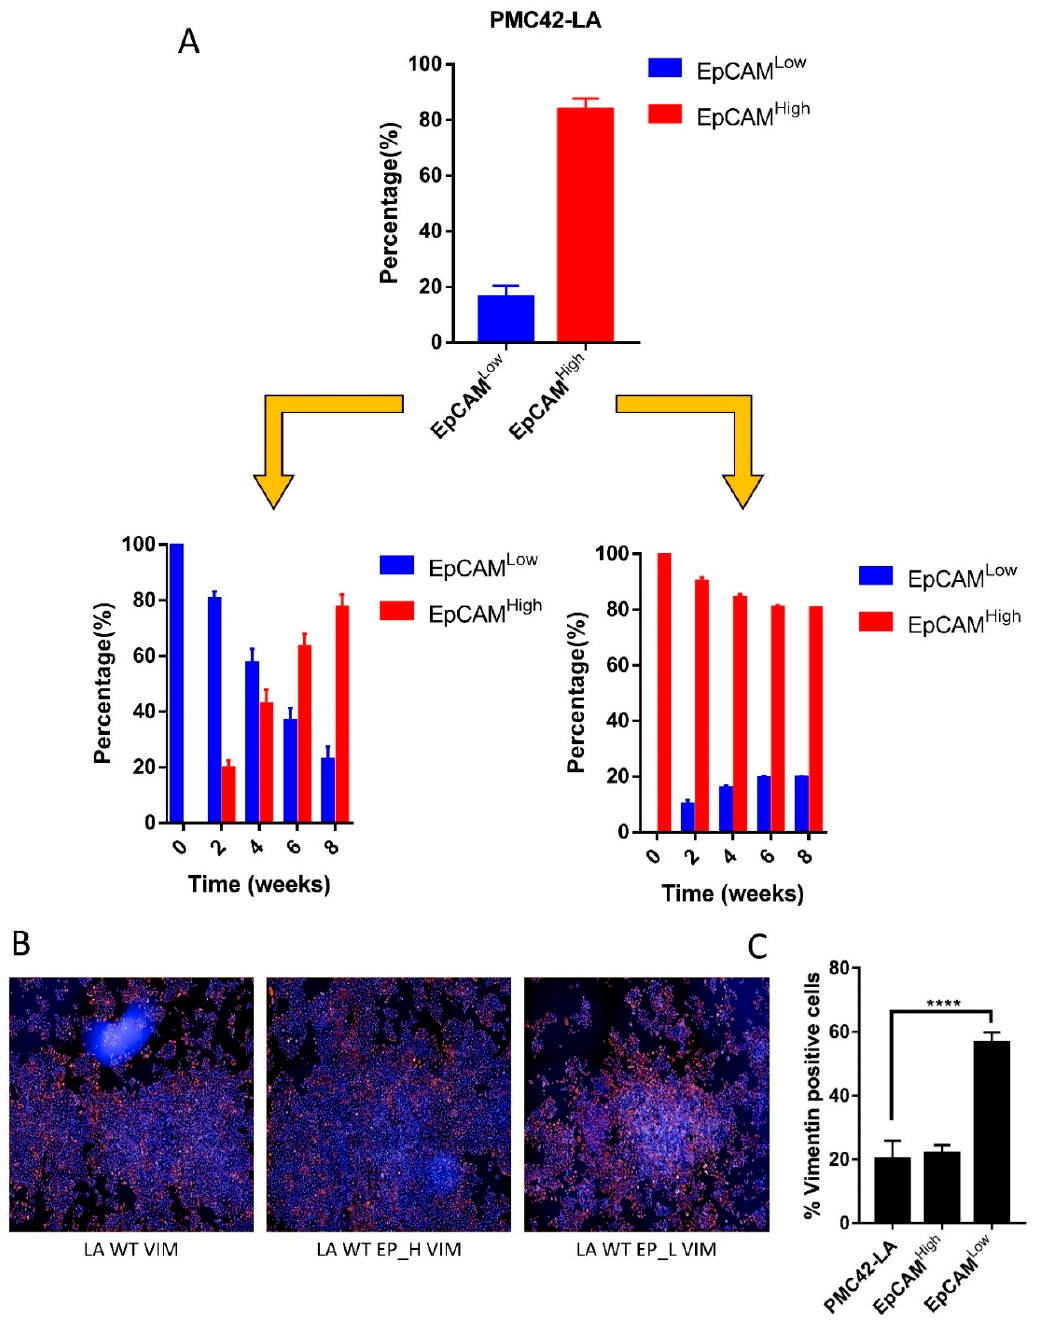
Figure 2. ( A ) Bar charts showing the proportion of cells in EpCAM low and EpCAM high state as intermittently assessed by FACS every two weeks from in vitro culture of FACS isolated EpCAM low and high subpopulations. Data analyzed using repeated measures ANOVA for temporal dynamics signify P = 0.0001 for EpCAM high transitions and P < 0.0001 for EpCAM Low transitions. ( B ) Immunofluorescence images captured on Operetta high-content imaging system and clustering of nine images at 10× resolution from the center of the well for vimentin expression. ( C ) Bar graph quantifying the number of cells positive for Vimentin expression across PMC42-LA parental and EpCAM sorted subpopulations using Operetta Harmony software. Significant differences were calculated using a paired t -test, **** P < 0.0001.